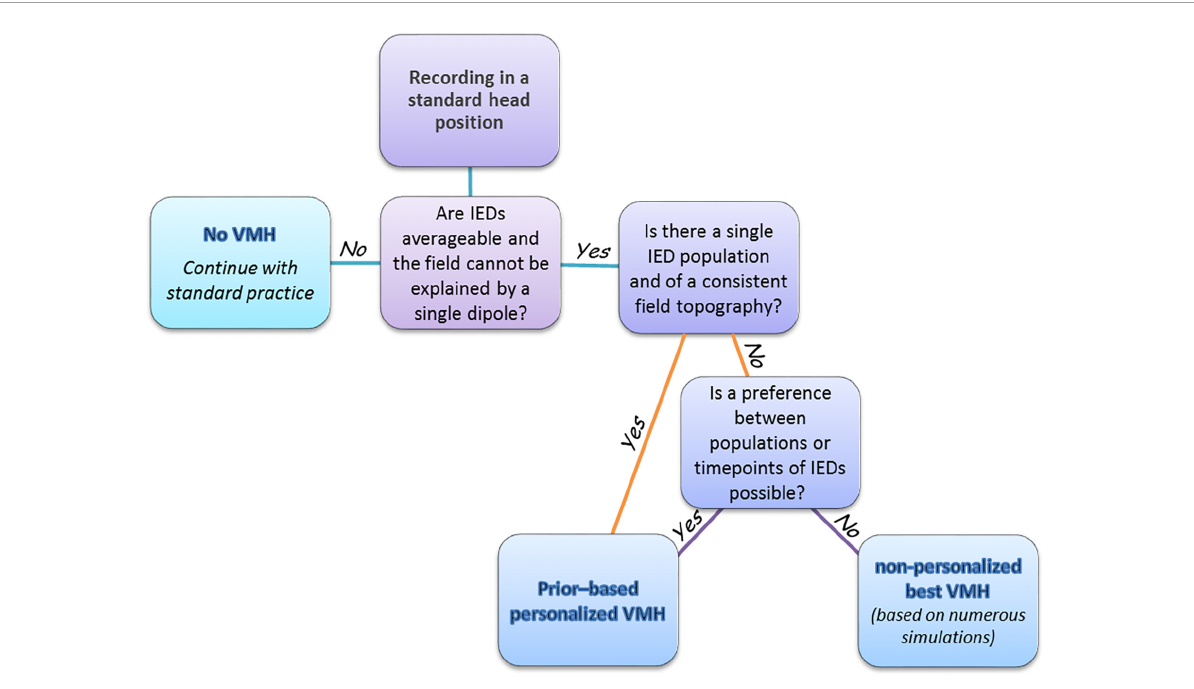
FIGURE7 A decision scheme for implementing VMH approach in pre-surgery epilepsy clinic. After recording in a standard head position for 1 h, the clinician reviews the spread of the collected IEDs, and determines whether to: (1) continue with standard practice or (2) personalize the VMH, or (3) construct a VMH that generally works well for the specific MEG apparatus. The generally well VMH is pre-designed based on numerous simulations of randomly distributed